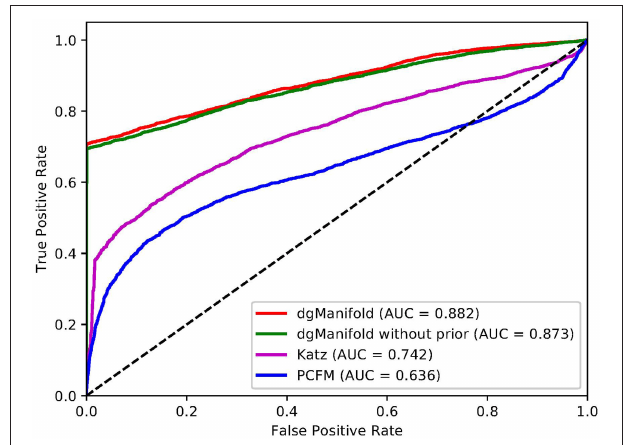
FIGURE 1 | ROC curves of the three competing algorithms on multiple-gene diseases.